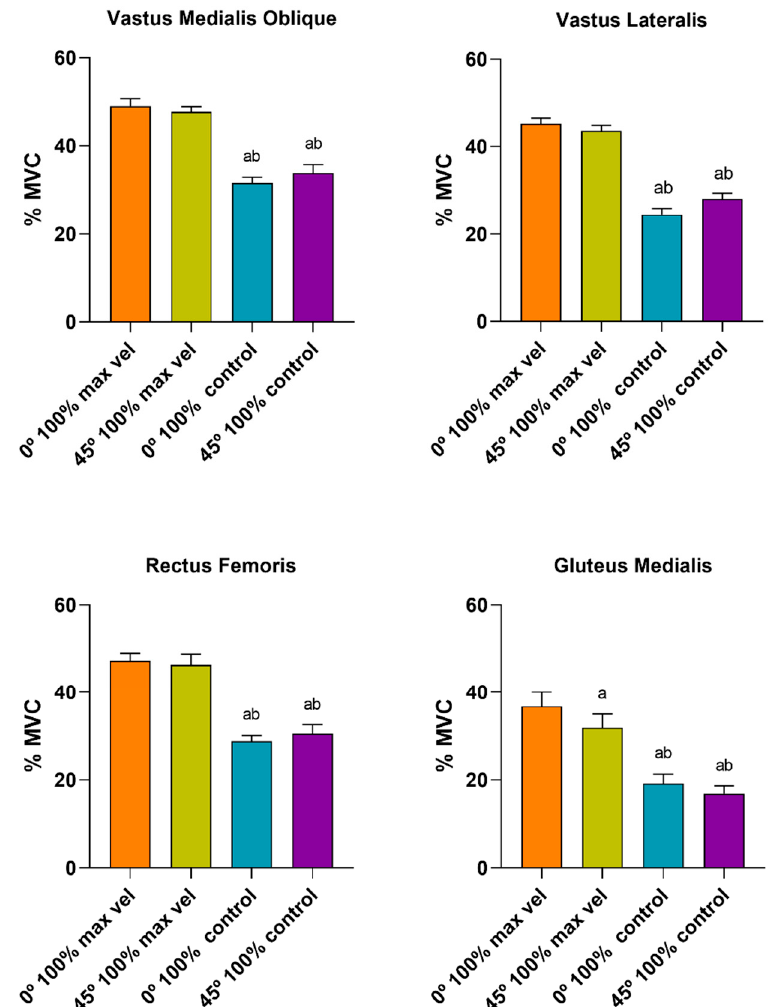
Figure 3. Comparison of concentric muscle activation for each muscle between 0° 100% and 45° 100%, performed at the maximal intended and controlled velocities ( ᵃ difference from 0° 100% max. vel., ᵇ difference from 45° 100% max. vel.; p < 0.05).